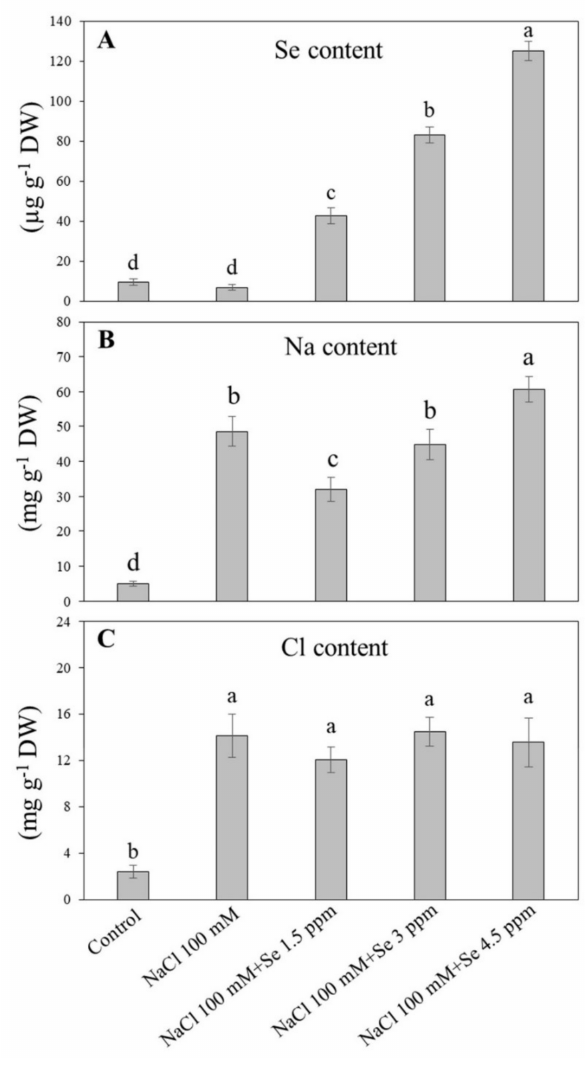
Figure 1. E ff ect of selenium (Se) fertilization on ( A ) Se uptake; ( B ) sodium (Na) uptake; and ( C ) chloride (Cl) uptake in leaves if black gram plants under salt stress. Values are mean ± standard error ( n = 3). Di ff erent letters in vertical columns show a significant di ff erence. A comparison of mean was confirmed by LSD at p <